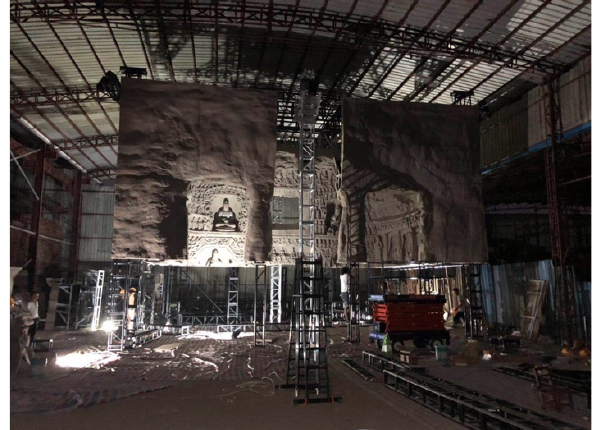
Figure 9. The portable support structure of the replica Cave 12 of the Yungang Grottoes